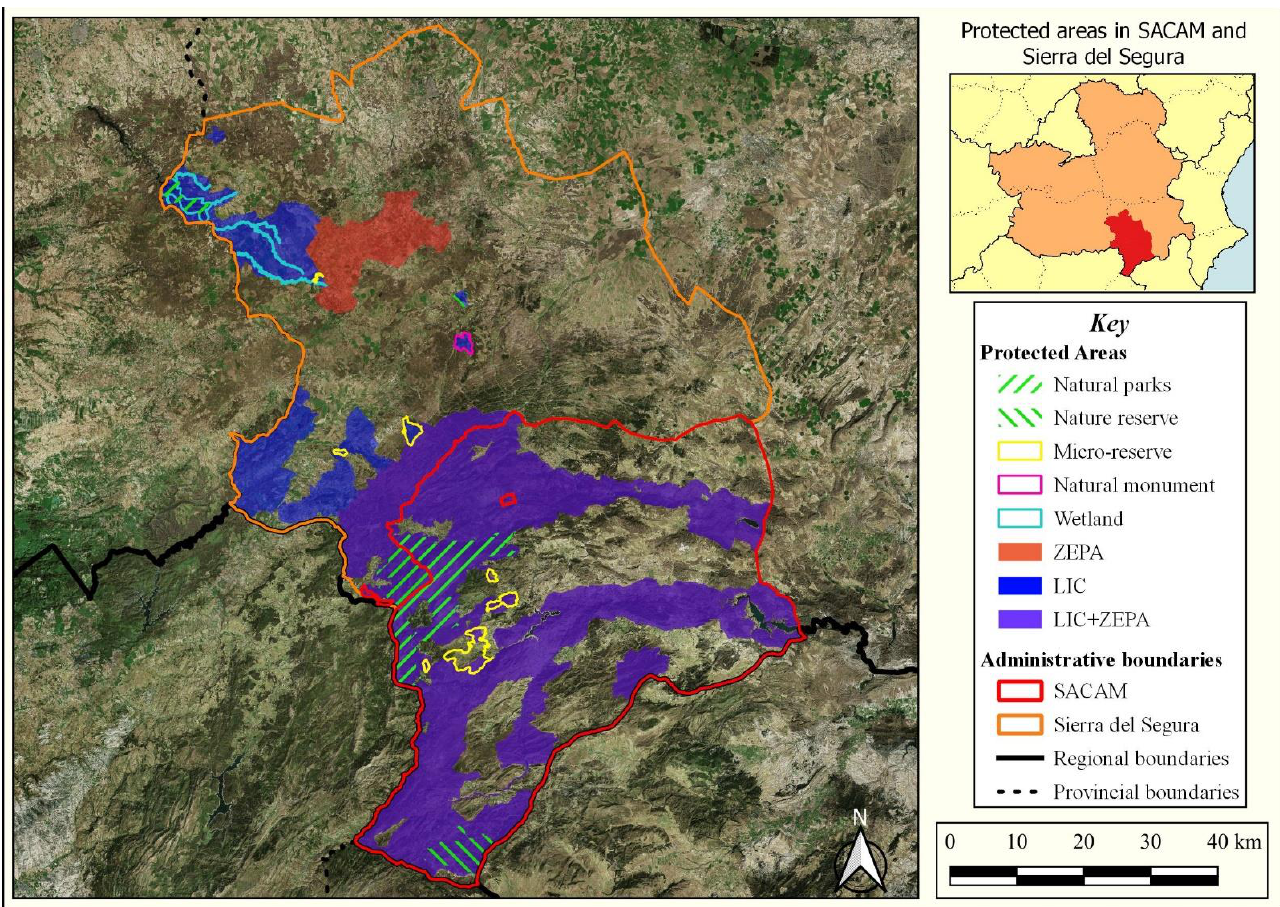
Figure 5. Protected areas (Source: Own preparation).